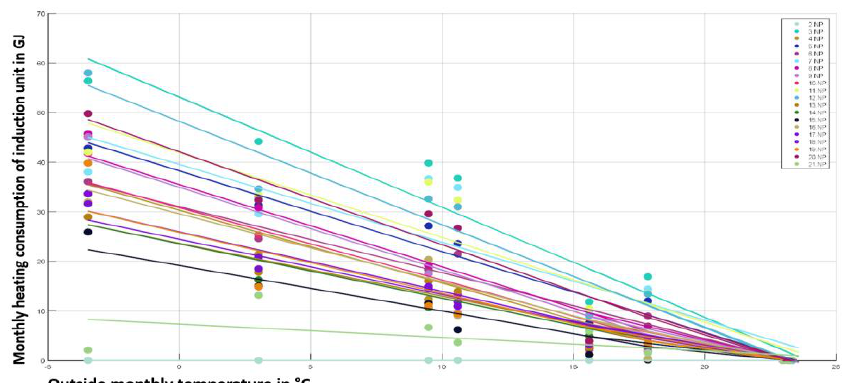
Figure 3: Monthly consumption of heating for every floor in comparison to average outside temperature. (Source: authors with the use of [9])